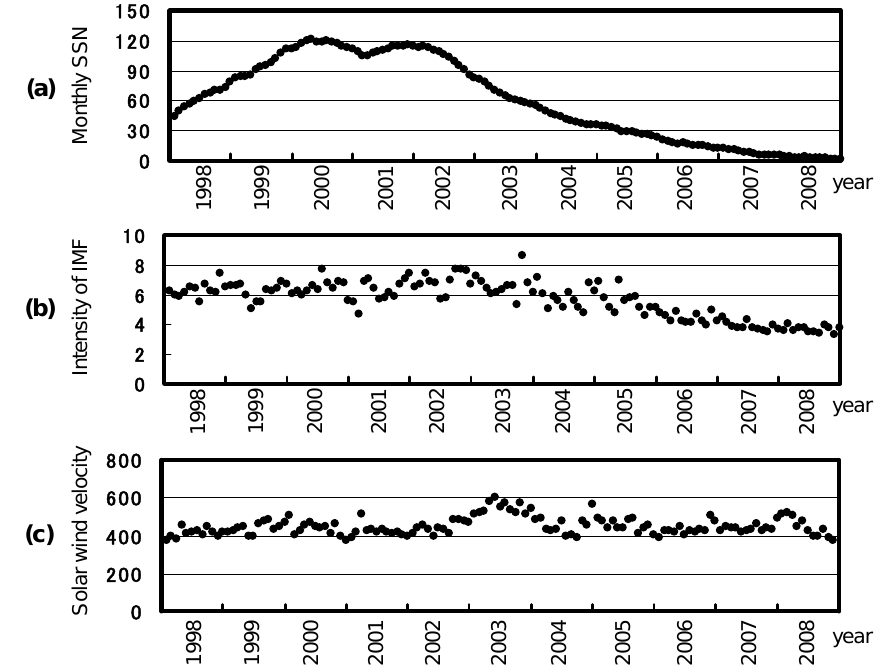
Fig. 8. Change in monthly smoothed sunspot number (a) , change in total intensity of the interplanetary magnetic field (b) , and change in the solar wind in the sun-earth direction during the period from 1998 through 2008 (c) . Level 2 hourly data taken by the ACE satellite is used for the interplanetary magnetic field and the solar velocity. The units for the magnetic fields are nT and solar wind velocity is km/s.